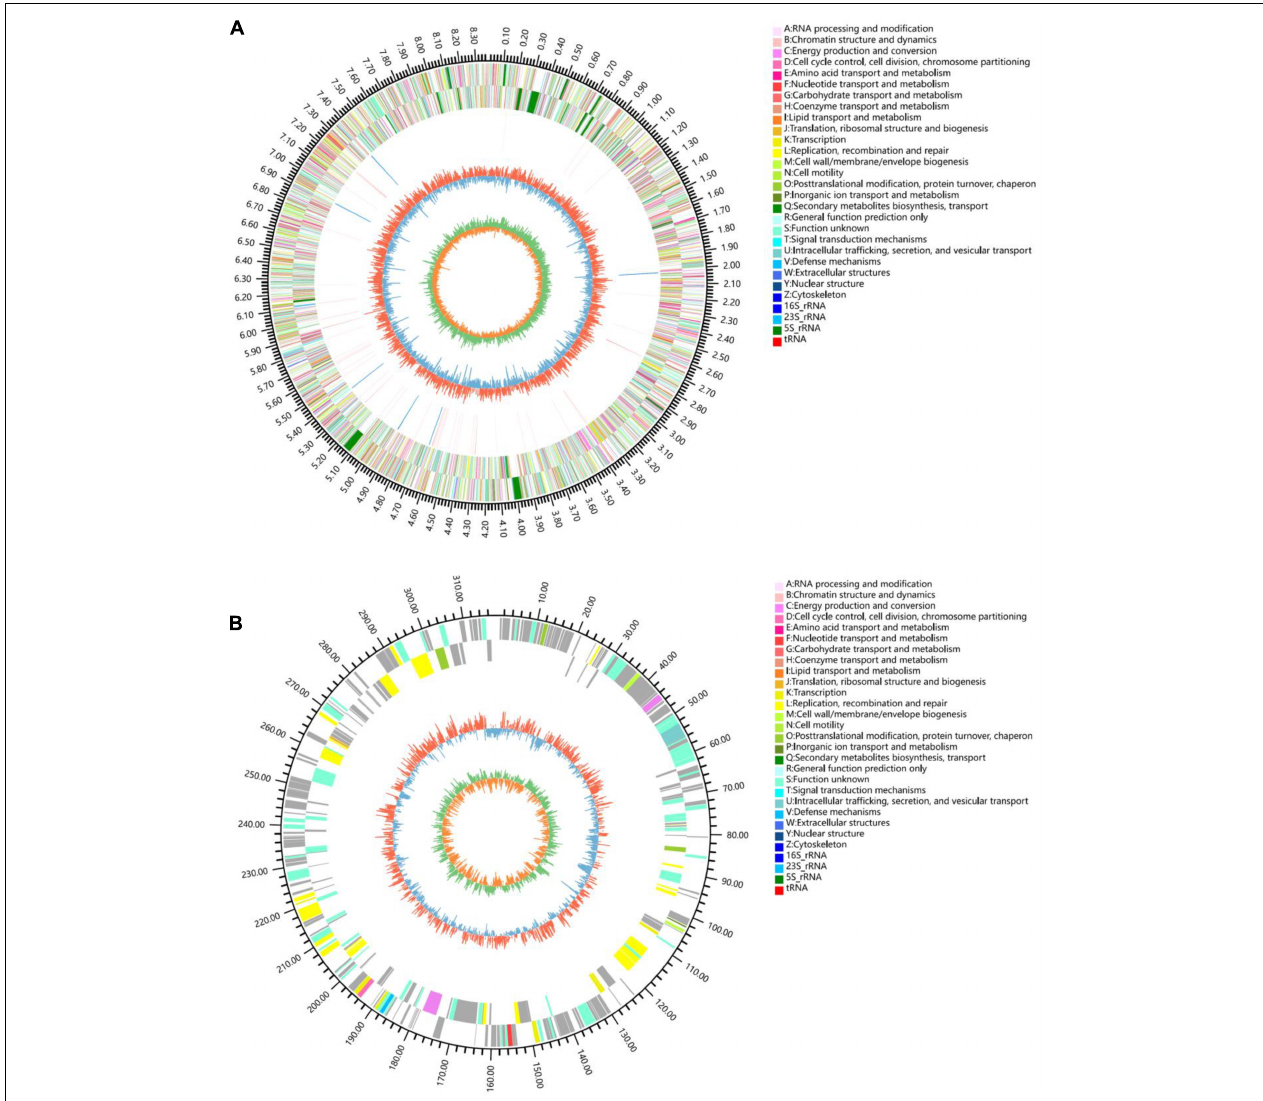
FIGURE 1 | Genome map of strain YINM00001. (A) Chromosome. (B) Plasmid. Tracks (from outer to inner): (1) genome size, (2) forward strand gene, colored according to COG classification, (3) reverse strand gene, colored according to COG classification, (4) rRNA and tRNA, (5) GC content, (6) GC skew.